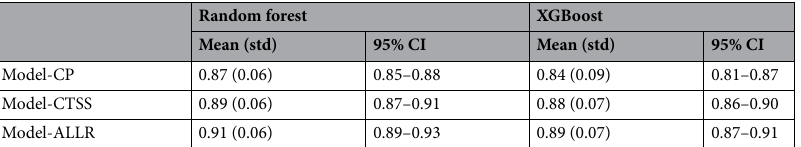
Table 2. Validation AUCs for 50 iterations for the three models. Model-CP model with clinical parameters as input, Model-CTSS model with clinical parameters and CT severity score as input, Model-ALLR model with clinical parameters and ALLR as